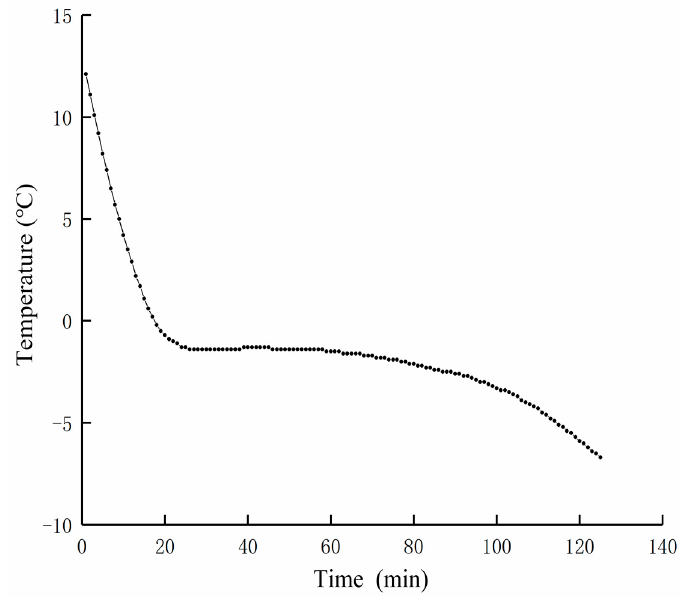
Figure 1. Beef freezing curve.